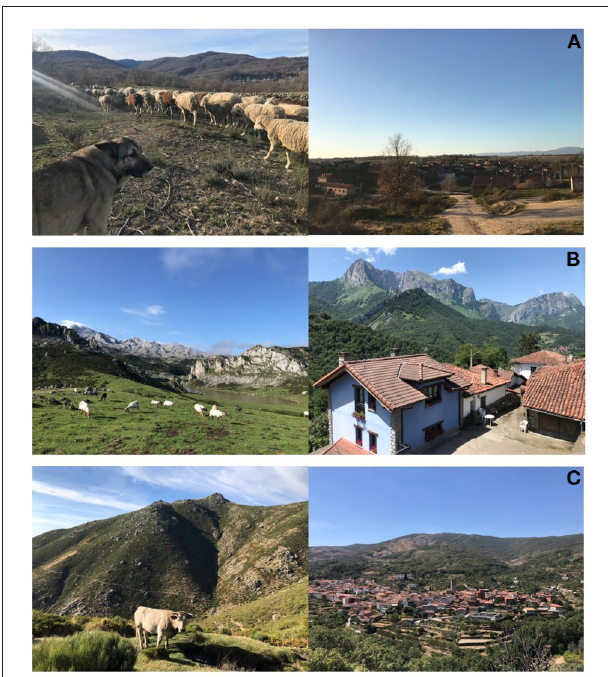
FIGURE 4 | Case study locations ( A–C , from top to bottom), exemplifying local farming systems (left), and village settings (right).